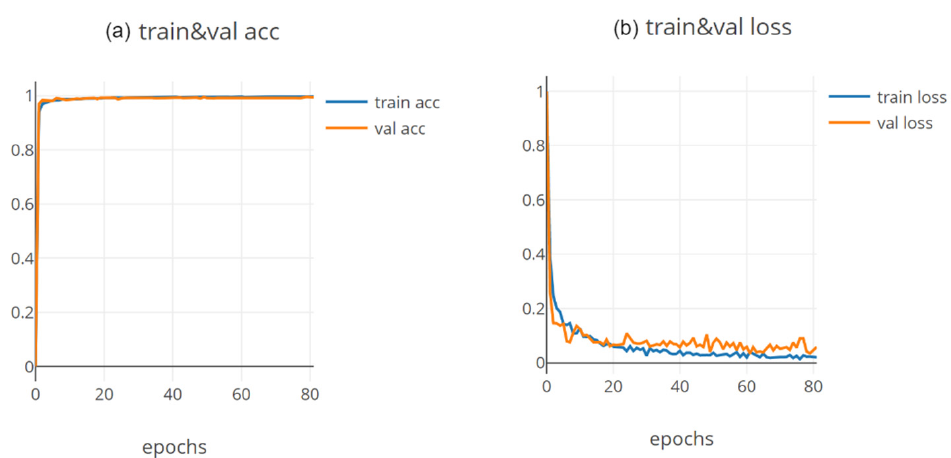
Figure 7. The epoch curves of loss and accuracy for training and validation data. ( a )The epoch curves of accuracy for training and validation. ( b )The epoch curves of loss for training and validation.